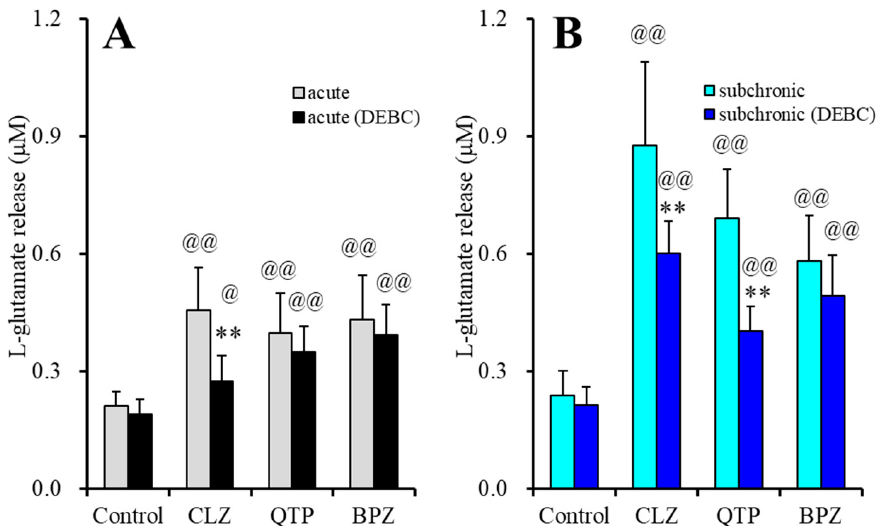
Figure 5. Effects of acute exposure to Akt inhibitor, 10-[4 ′ -(N,N-diethylamino)butyl]-2-chlorophenoxazine hydrochloride (DEBC: 10 µ M) for 120 min on enhanced L -glutamate release through activated hemichannel induced by combination of subchronic administration of therapeutic-relevant concentration of VPA (500 µ M) with acute ( A ) and subchronic ( B ) administration of CLZ (30 µ M), QTP (10 µ M) and BPZ (3 µ M). Ordinate: mean ± SD ( n = 6) of FCHK-evoked astroglial L -glutamate release ( µ M). Light and dark color columns indicate the incubation without (non) and with DEBC (10 µ M), respectively. ** p < 0.01: relative to non, @ p < 0.05, @@ p < 0.01 relative to control by MANOVA with Tukey’s post-hoc test.